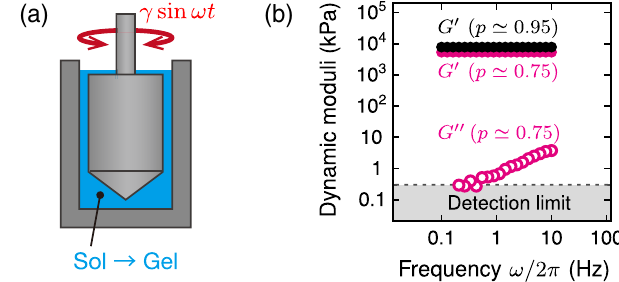
FIG. 3. Measurement of shear modulus. (a) Schematic illus- tration of the double-cylinder dynamic shear rheometer. Inside the rheometer, a solution of the precursors reacts to form a polymer gel. After the completion of the chemical reaction, the polymer gel is sheared cyclically in the gap between the inner cylindrical jig and the outer cup. (b) Frequency ( ω = 2 π ) depend- ence of the storage modulus G 0 and loss modulus G 00 . The molar mass M and concentration c of the precursors are 20 kg = mol and 60 g = L, respectively. The greater the connectivity p is, the lower tan δ is ( p is defined in the main text). For example, when p ≃ 0 . 95 (a nearly perfect network structure), G 00 is